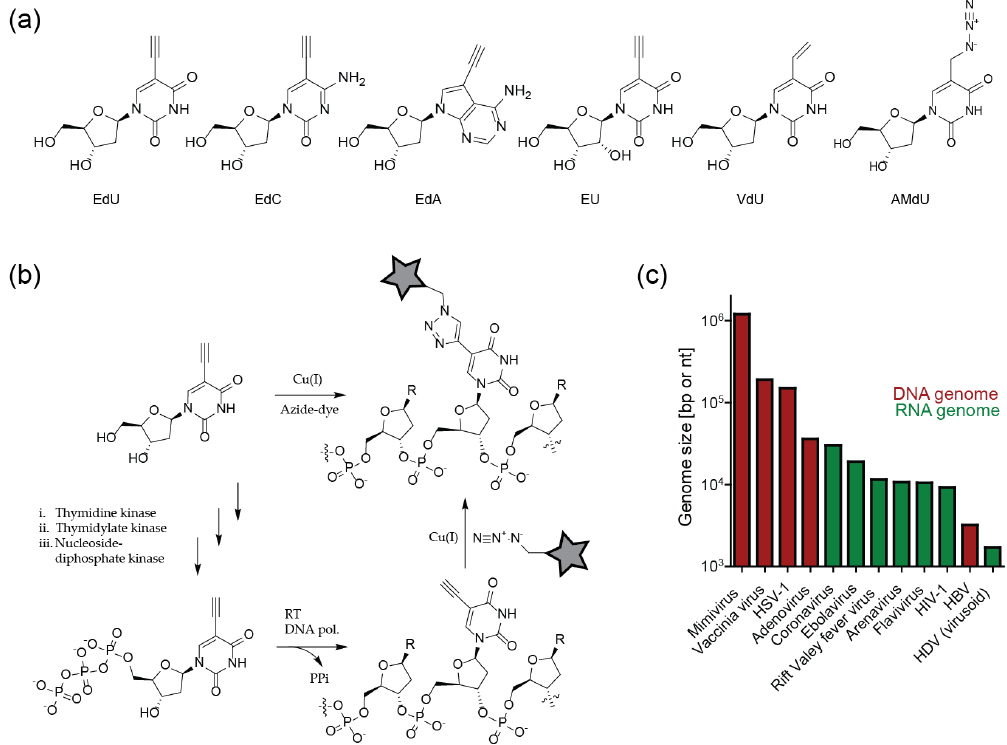
Figure 5. Labeling of viral nucleic acids by metabolic incorporation of unnatural nucleosides and click labeling. ( a ) Unnatural (deoxy)ribonucleosides suitable for click labeling approaches. ( b ) Intracellular phosphorylation and incorporation of an unnatural nucleoside/nucleotide and ligation to a fluorophore via CuAAC. ( c ) Sizes of exemplary viral genomes.